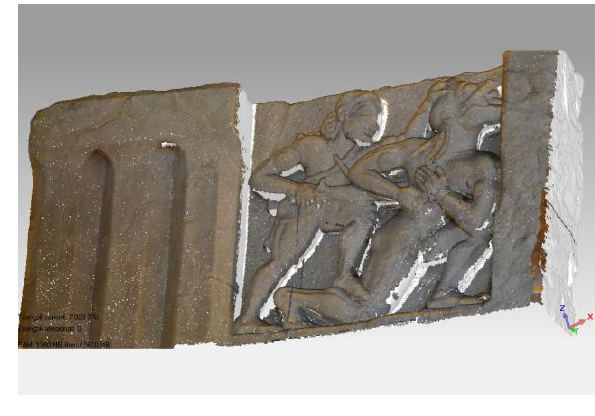
Figure 18. 3D model of the cell entrance